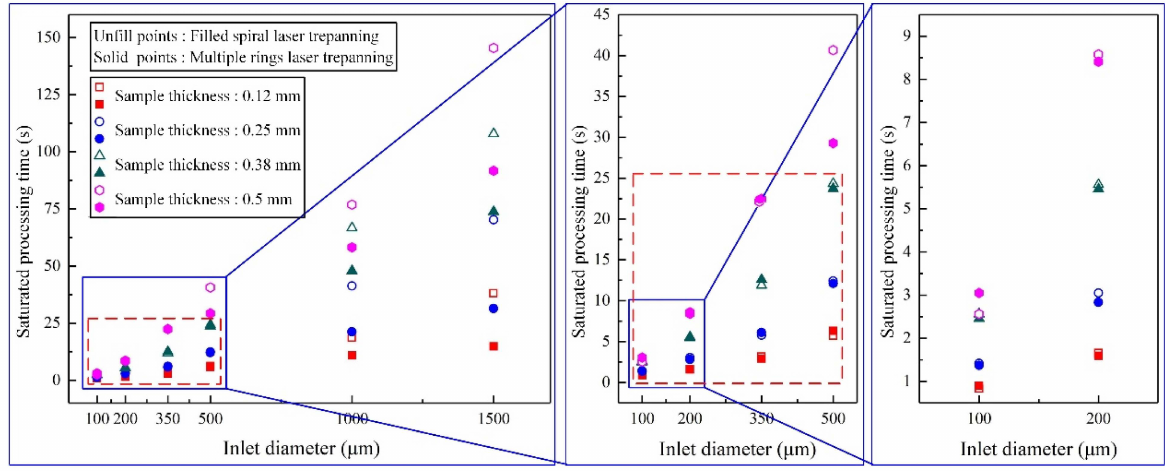
laser in Al 2 O 3 ceramics. When the inlet diameters were above 1000 µ m with 0.12 to 0.38 mm thick samples, and the above 500 µ m in 0.5 mm thick samples, the saturated hole processing times were longer for filled spiral laser trepanning (Figure 9). In other words, the multiple rings laser trepanning had higher efficiency. When the inlet diameters were below 350 µ m for all the considered sample thicknesses, and when the inlet diameters were below 500 µ m in 0.12 to 0.38 mm thick samples, the saturated hole processing times were similar for both methods, as shown in the red dotted boxes (Figure 9). Thus, in that case, the processing efficiencies were rather similar.